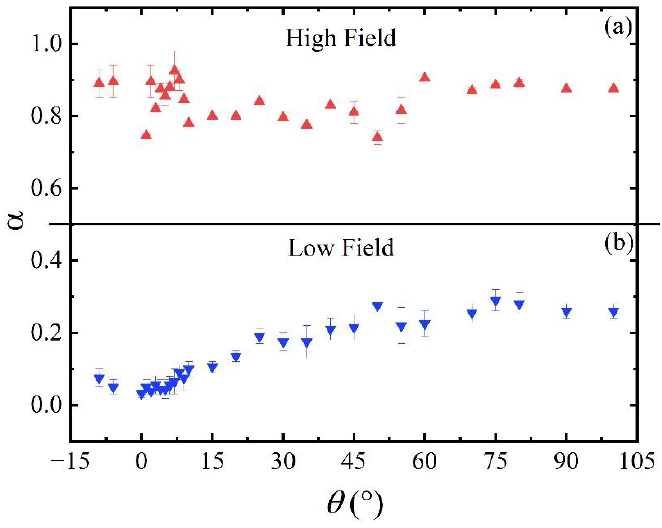
Figure 5. Values of α in ( a ) high and ( b ) low field ranges.